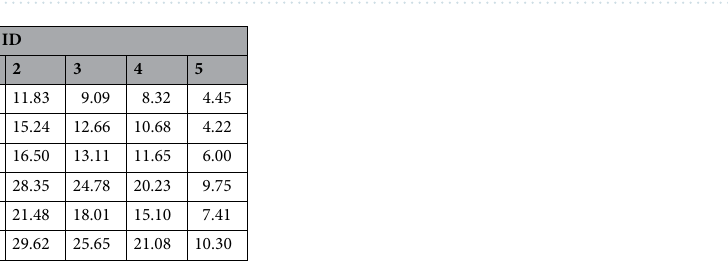
Table 3. Heat dissipation rate for each pulley under each CS working condition (W/s).